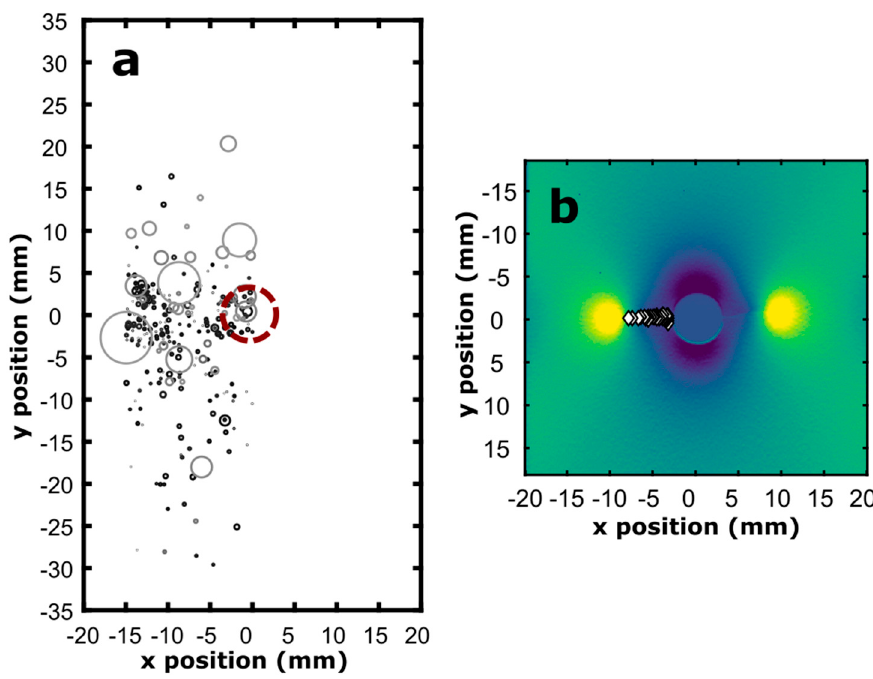
Figure 4. The location of ( a ) AE events as determined with Delta-T Mapping; darker circles are earlier in time, larger circles have higher absolute energy, and ( b ) crack positions as determined with the optical flow TSA method. For clarity, data are only shown on the side of the specimen where the first crack initiated. AE and TSA data are plotted on the same scale; AE region of interest (ROI) was larger in the vertical direction than the TSA data collection ROI.